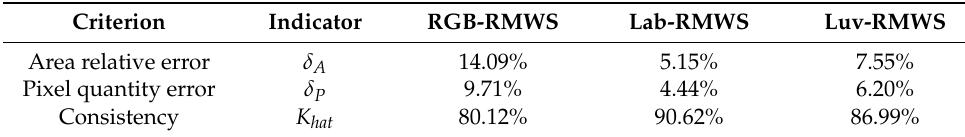
Table 7. Evaluation of the accuracies using the three